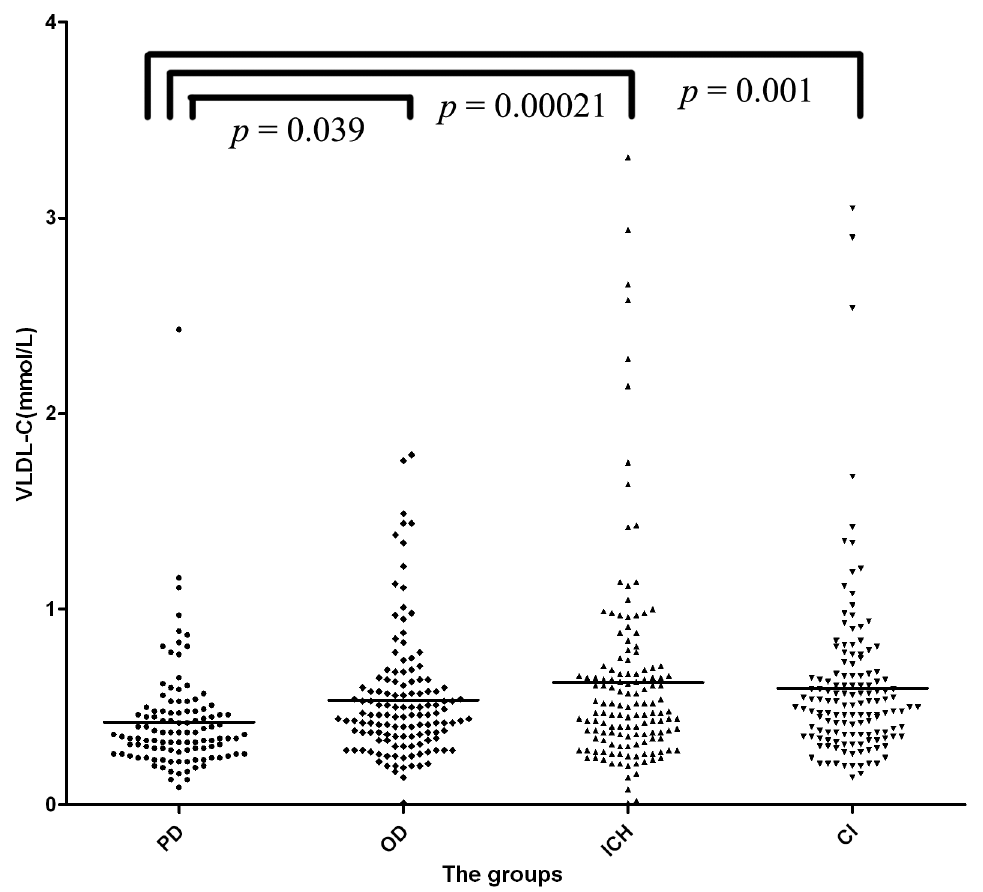
Figure 2. The serum level of Very low density lipoprotein cholesterol (VLDL-C) in the four groups. Very low density lipoprotein cholesterol (VLDL-C) serum level was significantly lower in PD group than in OD ( p =0.039), ICH ( p =0.00021) and CI ( p =0.001)